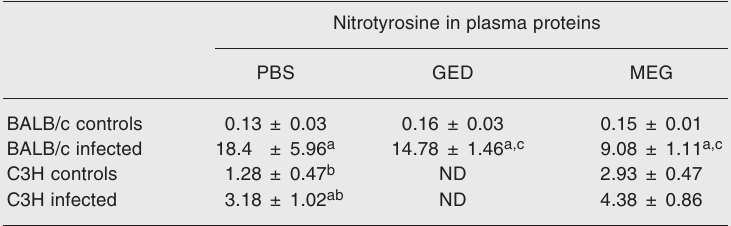
Table 2. Nitrotyrosine in plasma proteins of Trypanosoma cruzi -infected and treated mice and